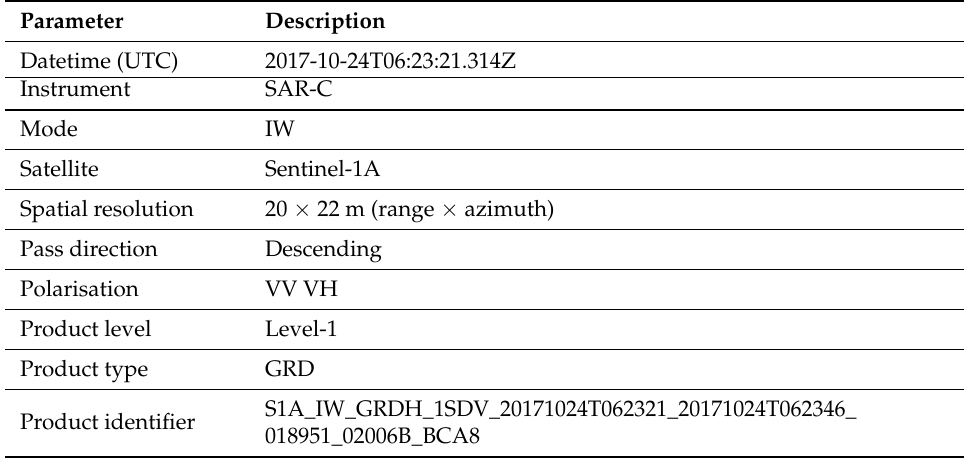
Figure 7. English Channel SAR product (VV polarisation). Table 5. English Channel SAR product